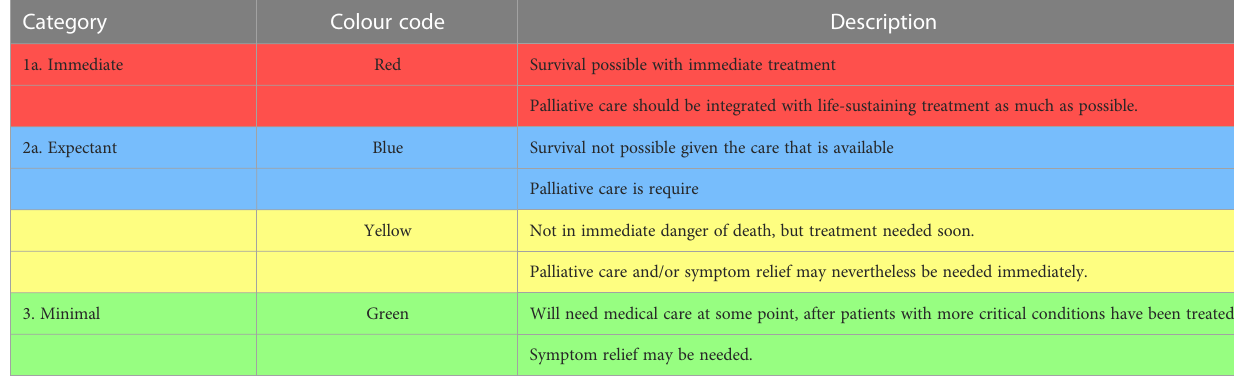
TABLE 1 WHO recommended triage categories in humanitarian emergencies and crises (1). Category Colour